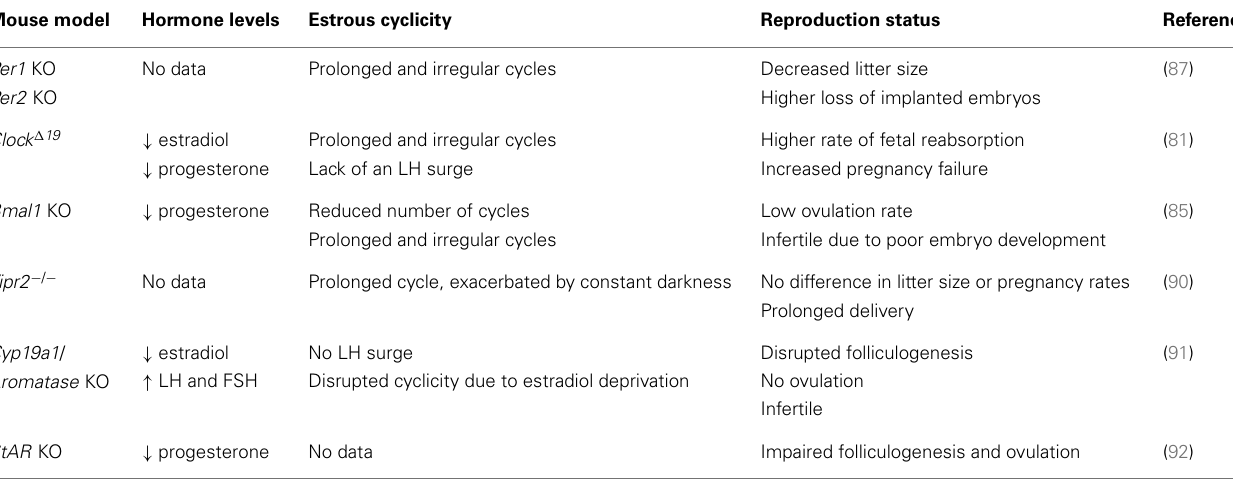
Table 1 |A comparison between different mouse knockout models in view of